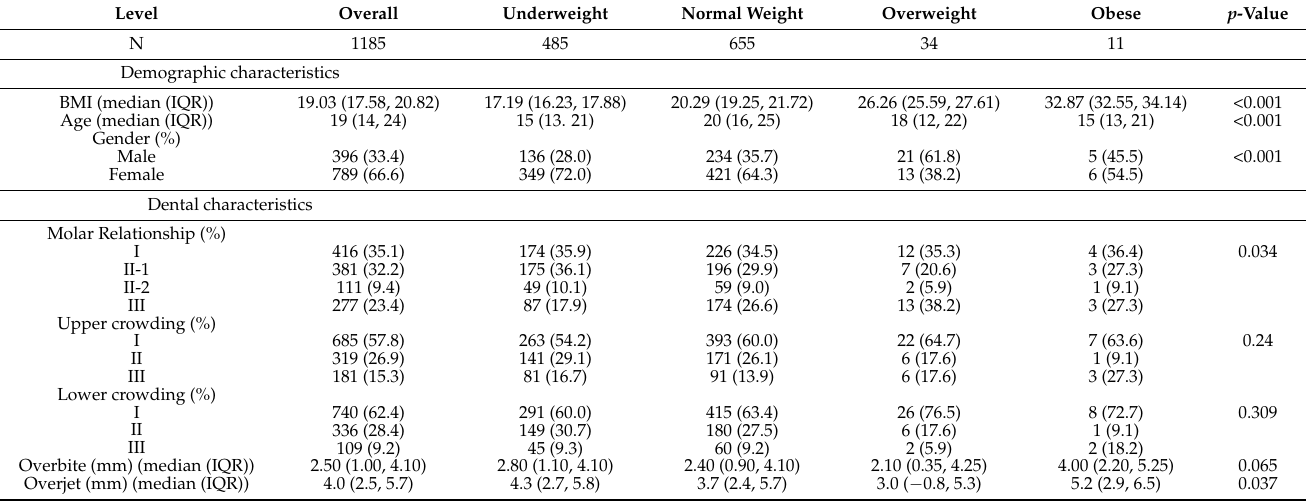
Table 2. Demographic and clinical characteristics of participants stratified by BMI